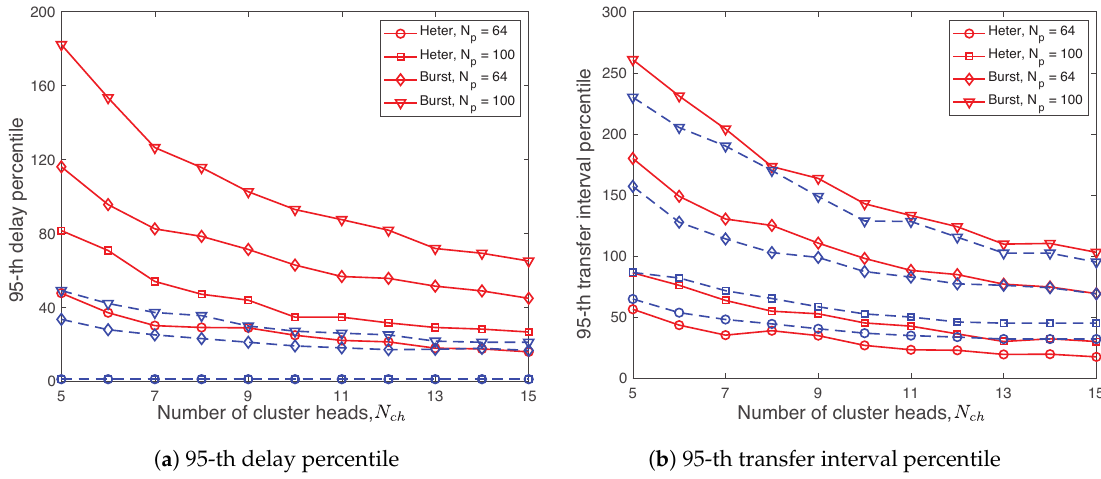
Figure 15. Delay and transfer interval percentiles using R-WSAN and the centralized protocol with N p = 64,100 and heterogeneous and burst links as a function of different number of cluster heads N ch = 5, . . . ,15. Increasing the number of cluster heads does not significantly improve the feedback delay and transfer interval for N ch >